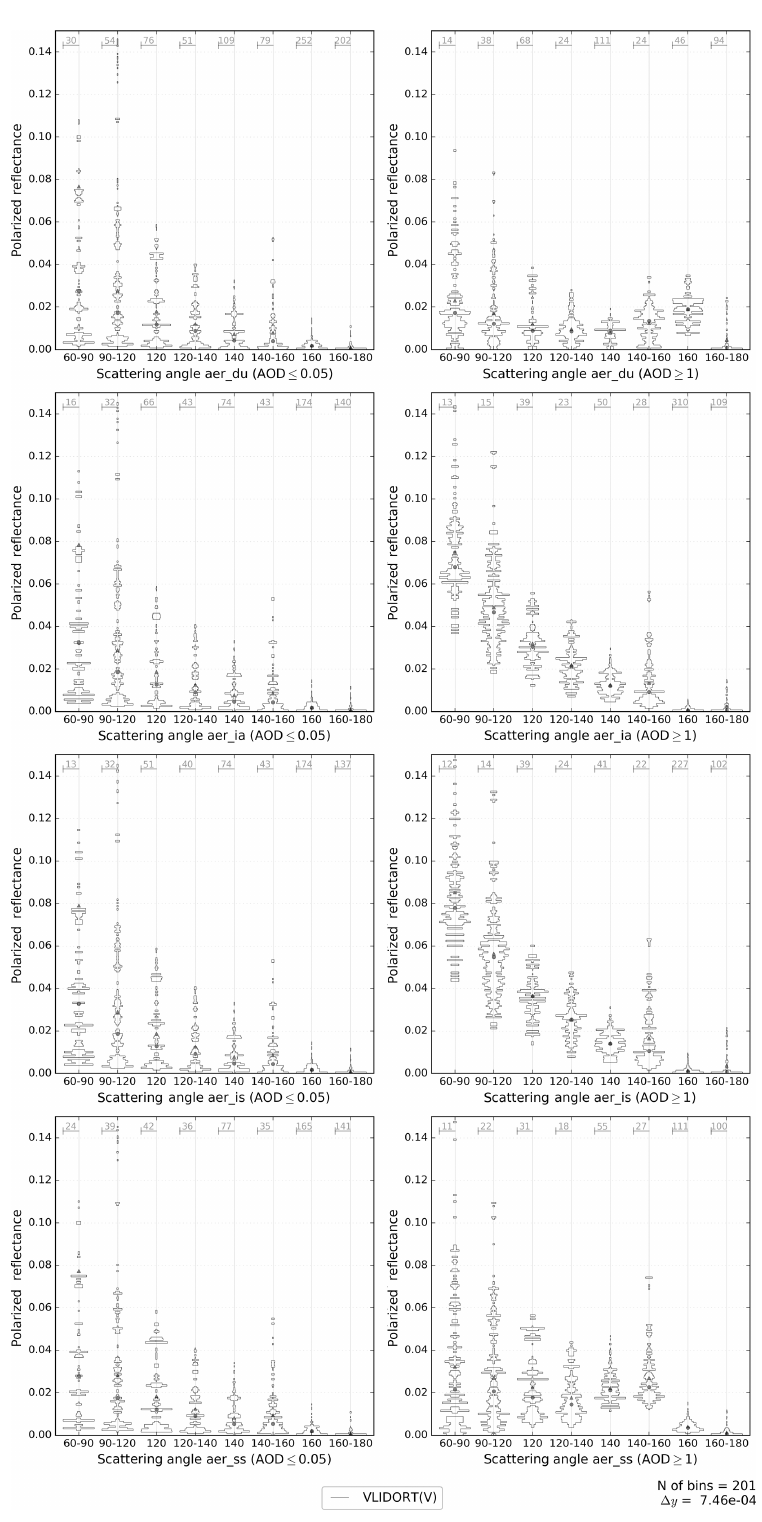
(cid:16) q (cid:17) ρ Q 2 + ρ U 2 Figure A4. Histograms for the polarized reflectance of the VLIDORT (vector) computed reflectances. Only for AOD ≤ 0 . 05 in the left column and AOD ≥ 1 in the right column (AOD at 550nm). The scattering angle has been binned at intervals with similar quantities of data points. The four aerosol types considered in this work are shown in different